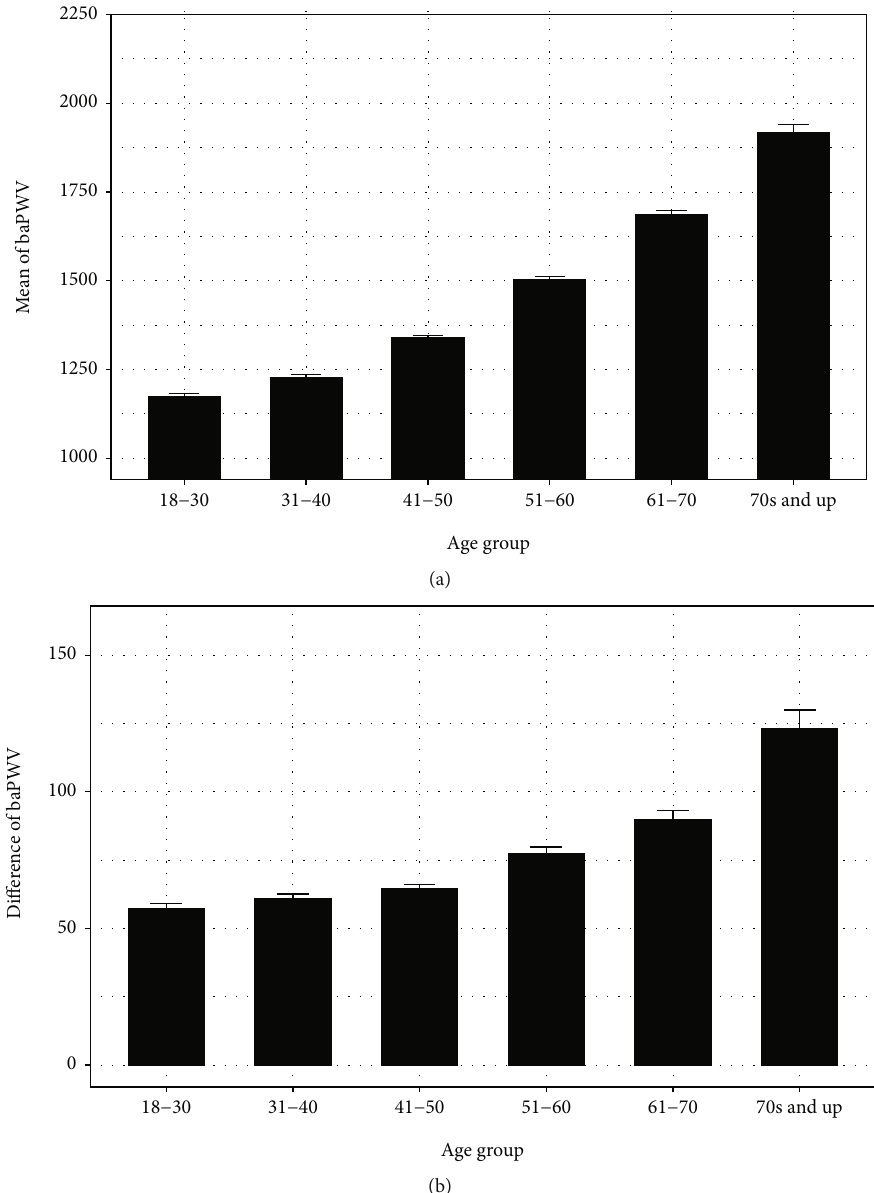
Figure 4: The temporal pattern of baPWV and bilateral baPWV ( Δ baPWV) values (a) The temporal pattern of baPWV values. A gradual increase in baPWV was observed with respect to age, suggesting an increase in the sti ff ness of arterial vessels as aging progresses. (b) The temporal pattern of Δ baPWV values. The absolute value of di ff erences between left and right baPWV values is referred to as bilateral baPWV ( Δ baPWV). Similar to baPWV, the values and variances of Δ baPWV increase with respect to